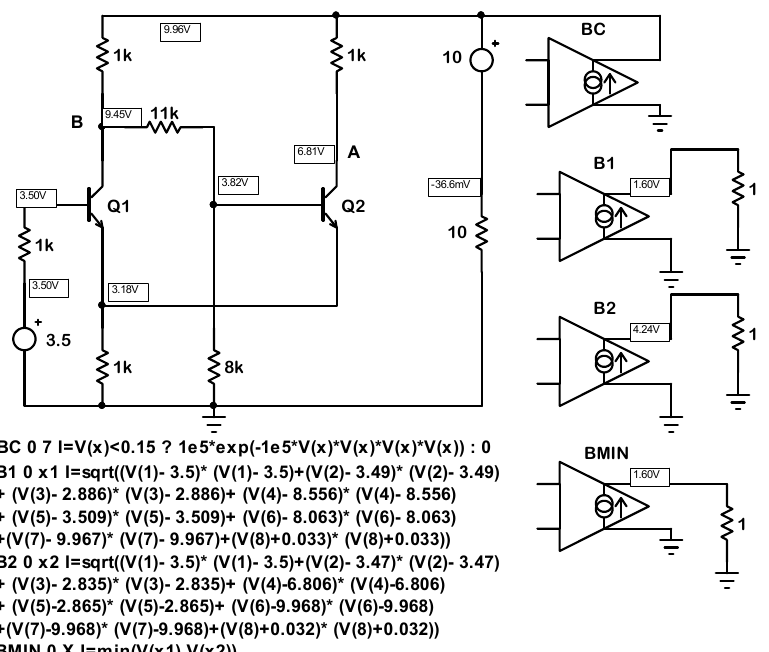
Figure 4. Modified, according to the idea of deflation, circuit shown in Figure 3 and the results corresponding to the third DC solution ( k = 3).